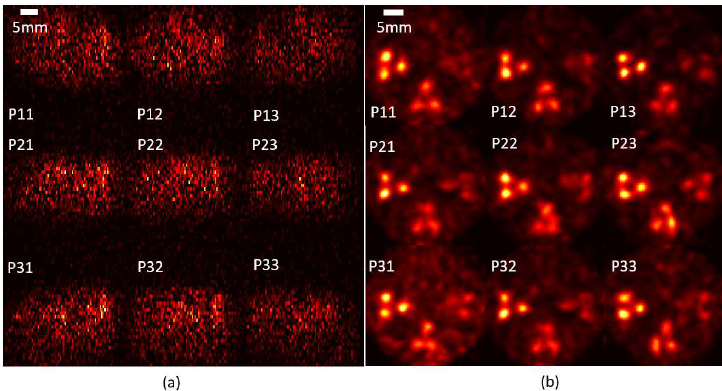
Figure 7. ( a ) Projection and ( b ) reconstructed images for single pinholes of PMP geometry.